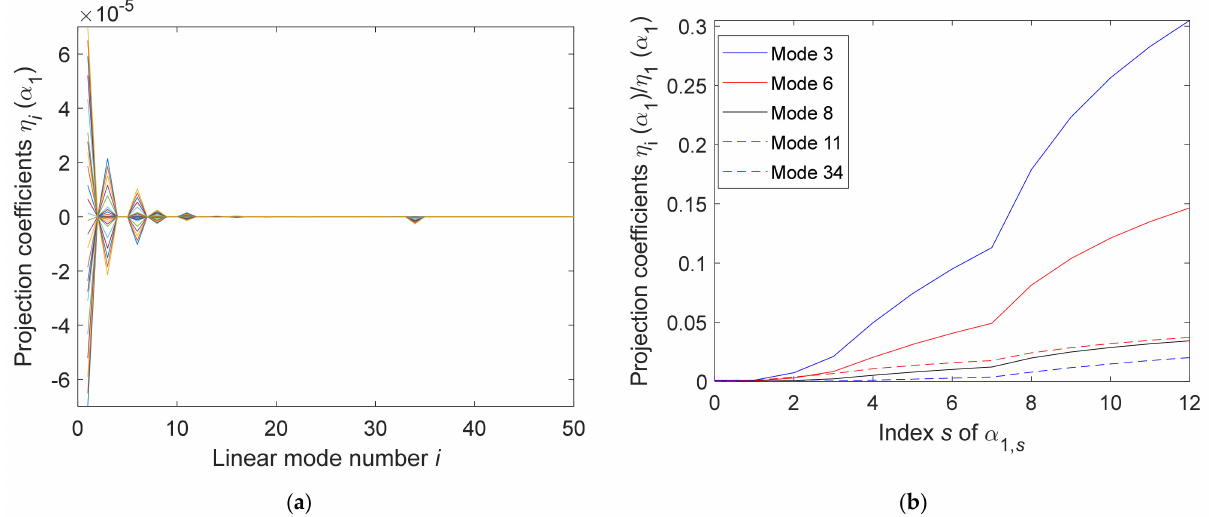
Figure 20. Projection coefficients η i ( α 1 ) of the static responses w 1 ( α 1 ) . Beam on spring supports from Figure 19. ( a ) η i ( α 1 ) vs. linear mode i for all load levels α 1, s . ( b ) Normalized coefficients ( α ) / η ( α ) | vs. load level α | η 1 1 1, s for selected modes i = 3, 6, 8, 11, and i 1